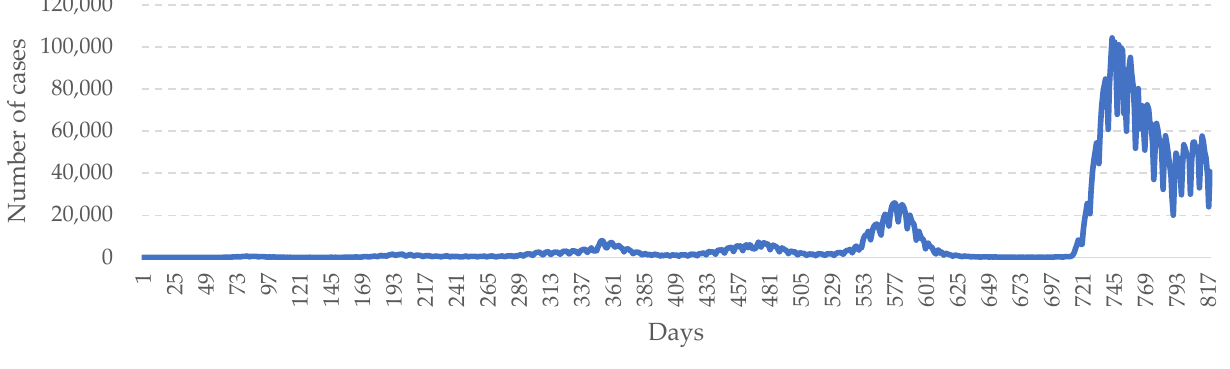
Figure 5. Daily new confirmed COVID-19 cases in Japan. (January 2020–April 2022).